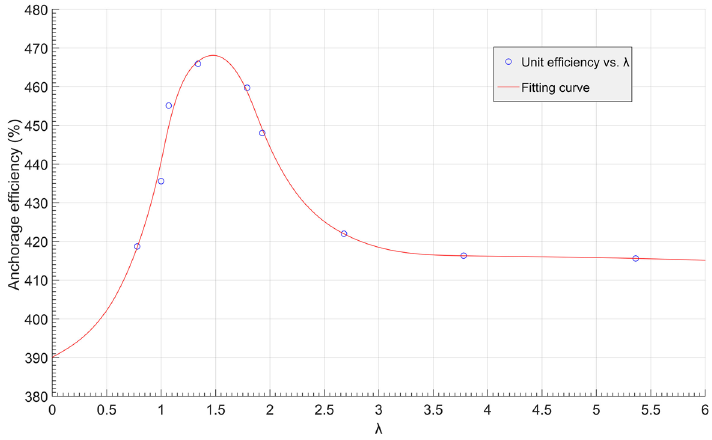
Figure 22. Anchorage efficiency vs. (cid:31)